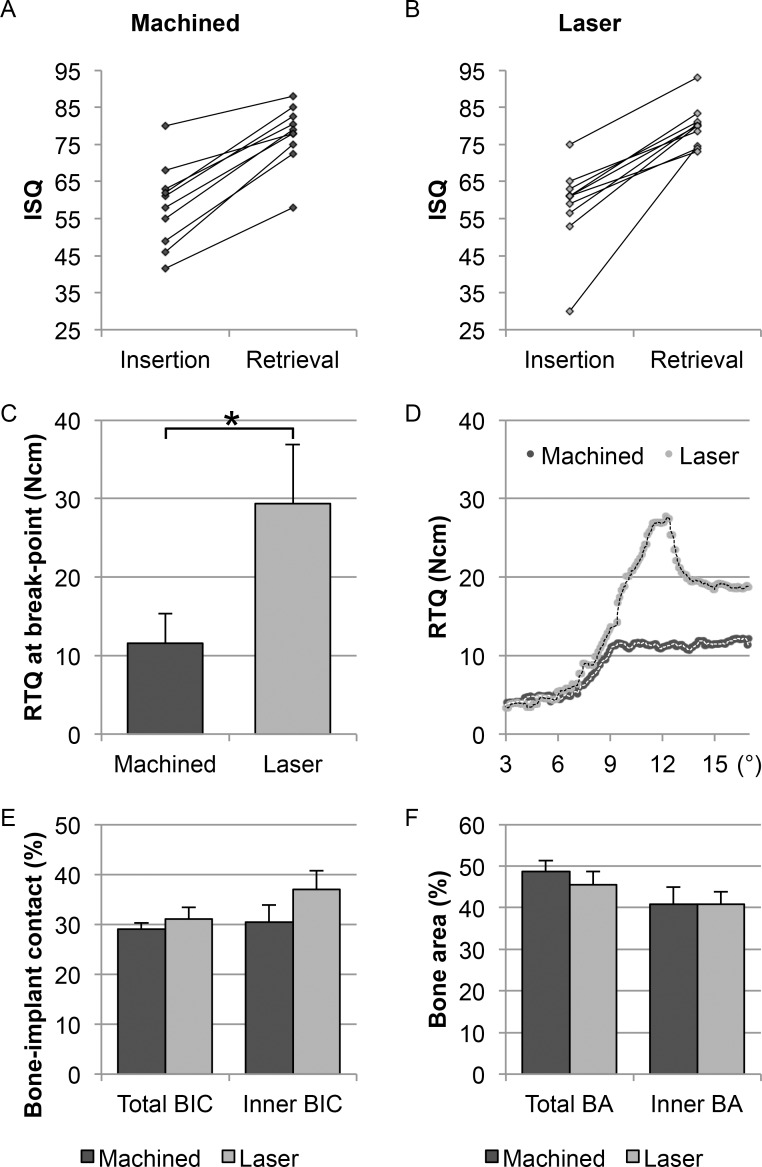
RFA, RTQ, load deformation and histomorphometry.(A-B) Resonance frequency analysis (RFA) showing changes in ISQ values over time. (C) Removal torque (RTQ) at break-point. (D) Typical load deformation curves (applied load vs. angular deformation) for the machined and the laser-modified implants showing the distinctly different patterns of mechanical failure at a constant rate of 0.2°/s. (E-F) Histomorphometry. The total bone-implant contact (BIC) and the total bone area (BA) in the threads were determined along the entire length of the threaded part of the implant. The inner BIC and the inner BA were determined in the inner 1/3 of the threads of the respective implant types.